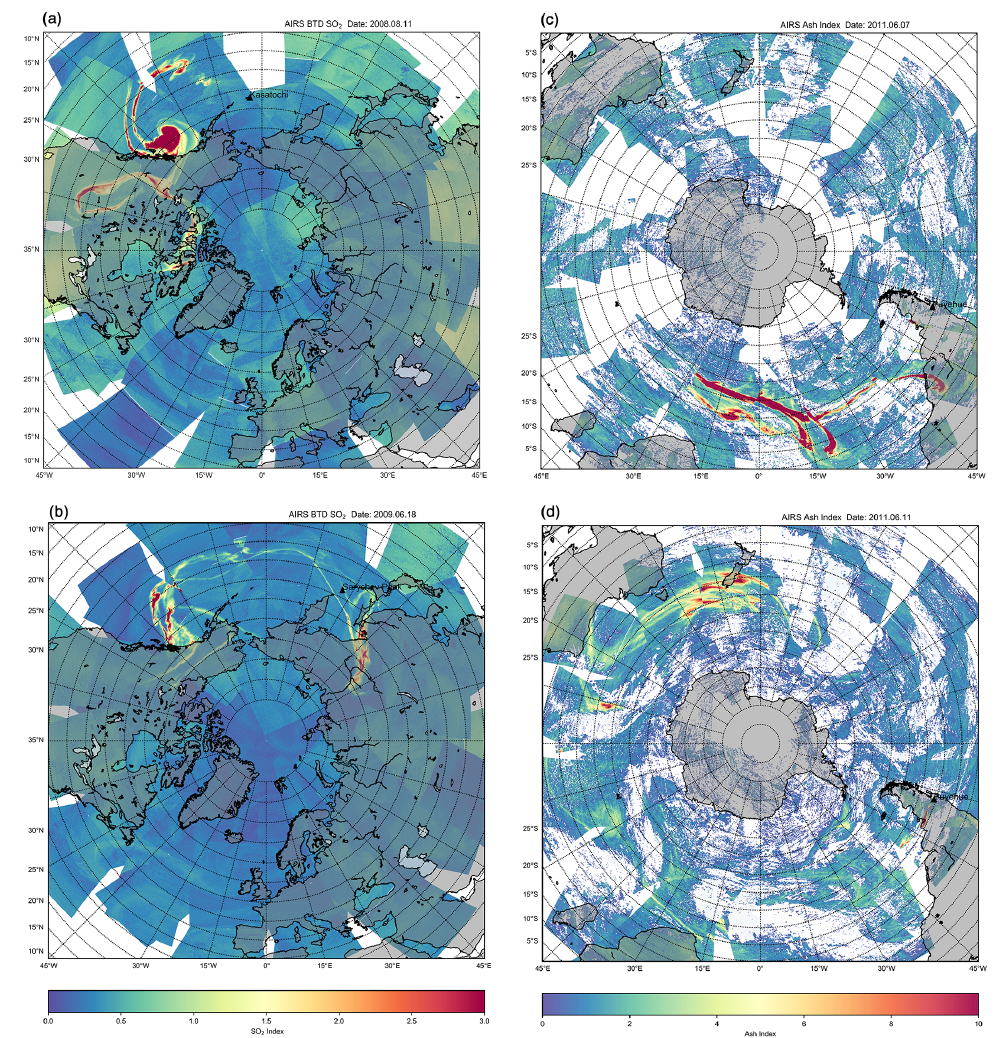
Figure 25. Hemispheric maps of the dispersion of SO 2 and ash, based on infrared derived indices. ( a ) Kasatochi SO 2 11 August 2008. ( b ) Kasatochi SO 2 16 August 2008. ( c ) Puyehue-Cordón Caulle ash 7 June 2011. ( d ) Puyehue–Cordón Caulle ash 11 June